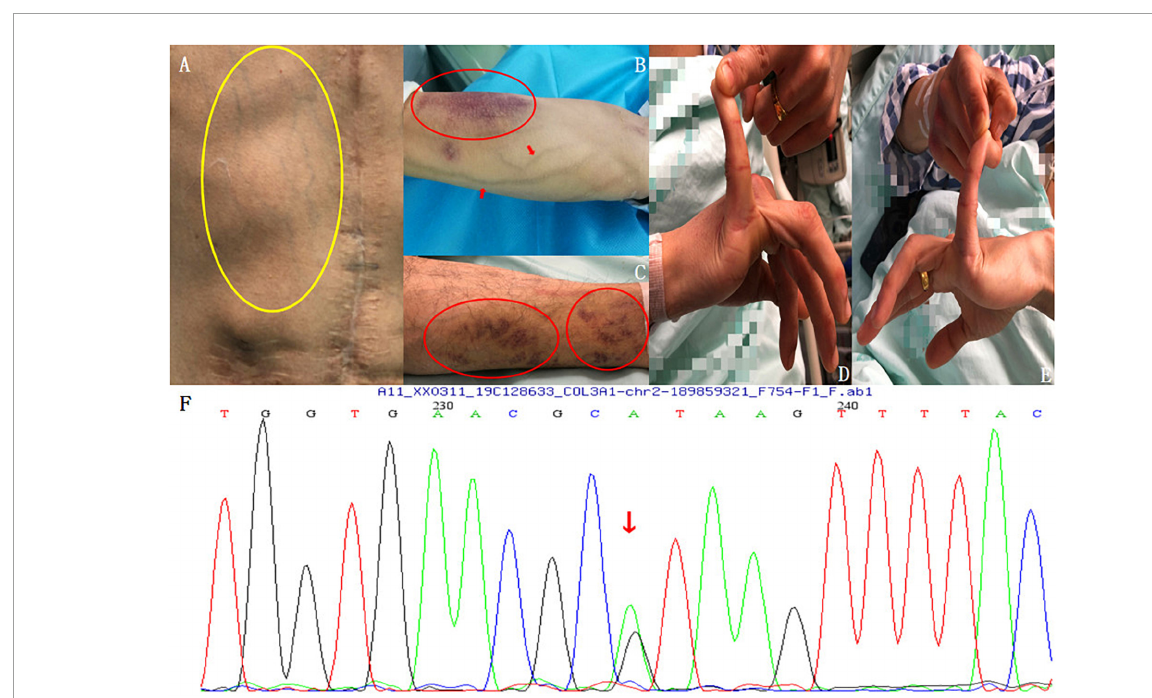
FIGURE2 Physical examination findings. (A) Thin skin, increased skin elasticity, and obviously exposed subcutaneous veins of the chest wall (yellow circle). (B) Visible veins and subcutaneous ecchymosis (red circle) on the forearm. (C) Visible subcutaneous ecchymosis on the lower limbs (red circles). (D,E) Abnormally increased mobility of the bilateral little finger MCP joints. (F) Genetic testing: A heterozygous mutation of c.1347 + 1G > A in the COL3A1 gene was found and verified using PCR and Sanger sequencing, which led to a protein sequence splicing